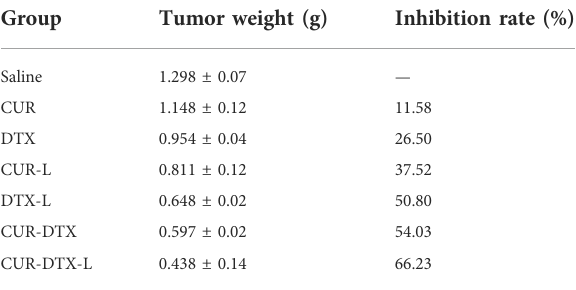
TABLE 5 Anti-tumor ef fi cacy of tumor-bearing mice with saline, CUR, DTX, CUR-L, DTX-L, CUR-DTX, and CUR-DTX-L treatment ( n = 3).